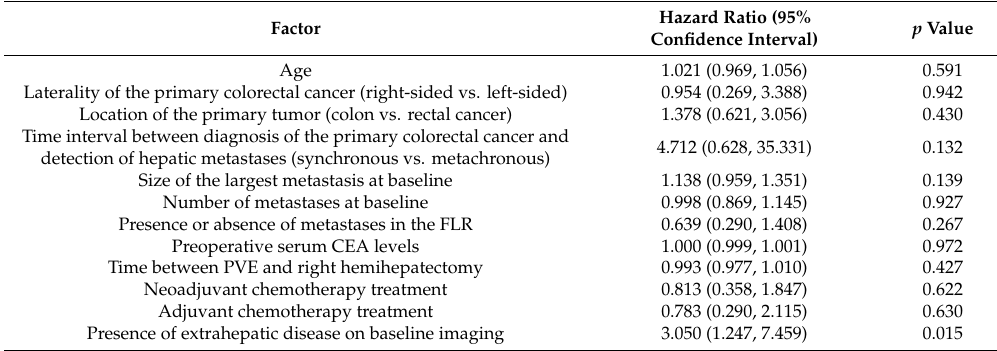
Table 3. Results of the univariable Cox regression analysis for overall survival. CEA: carcinoembryogenic antigen, PVE: portal vein